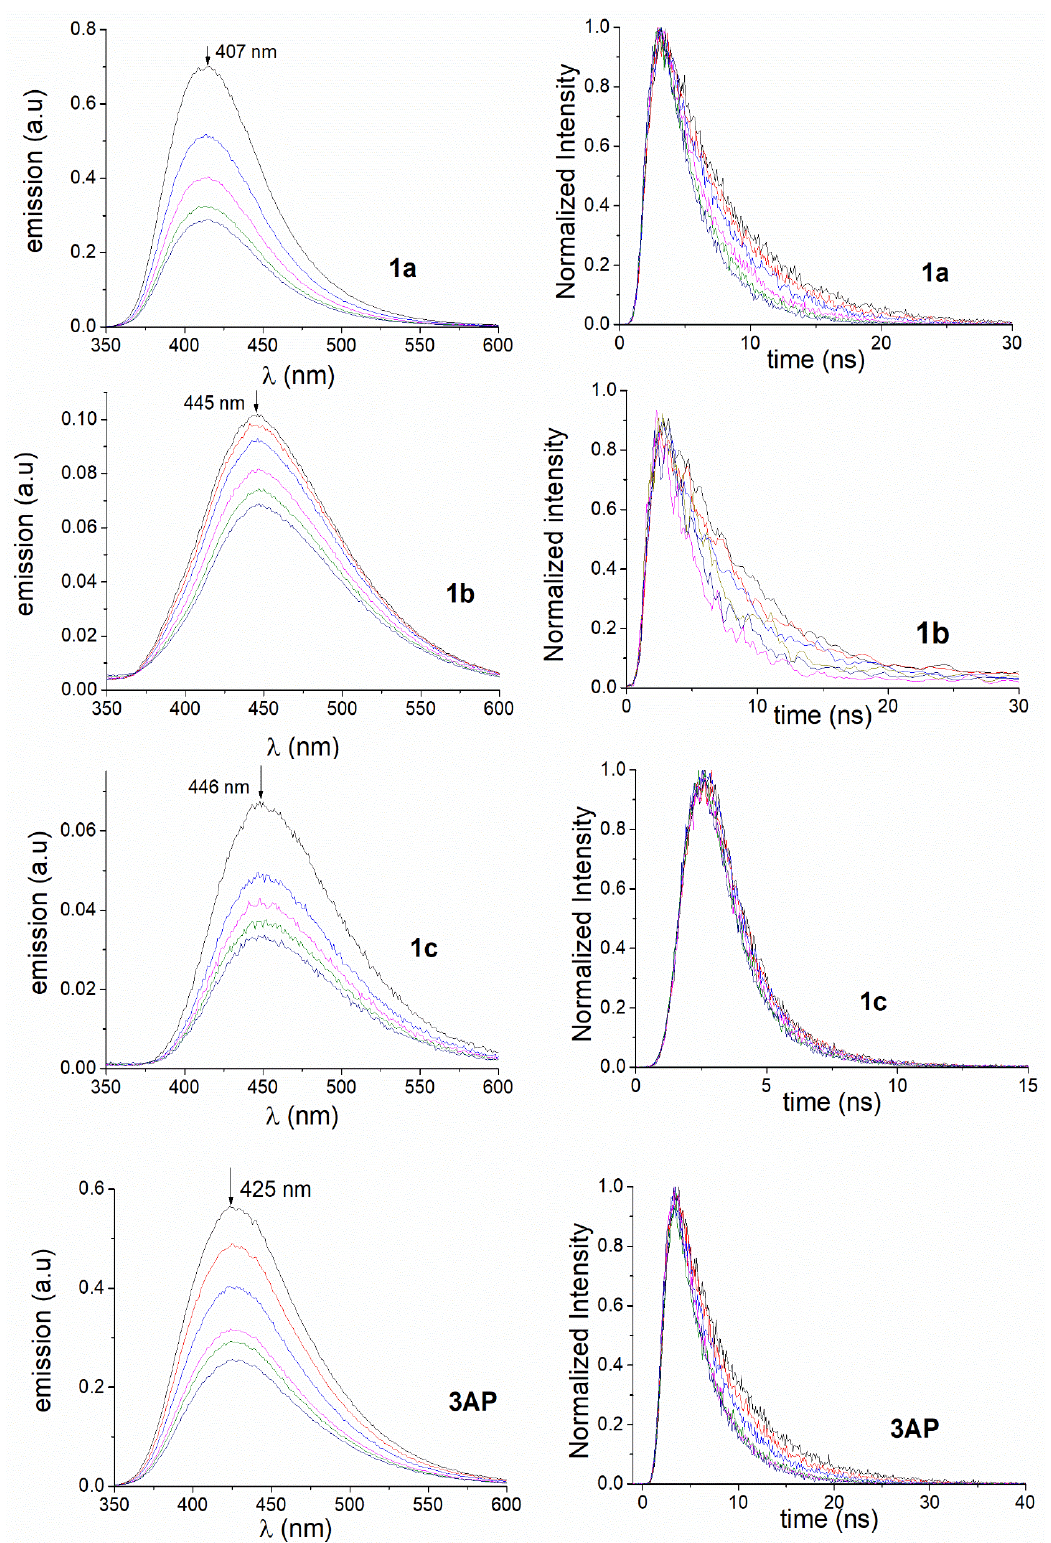
Figure 4. Emission spectra ( left ) and fluorescence decays ( right ) for compounds 1a – c and 3AP obtained in PBS (0.1 mM) in the presence of increasing amounts of ETPP (0–42.1 mM; colour codes: 0 mM black line, 4.6 mM red line, 11.4 mM blue line, 22.2 mM pink line, 32.4 mM green line, 42.1 mM navy blue line).